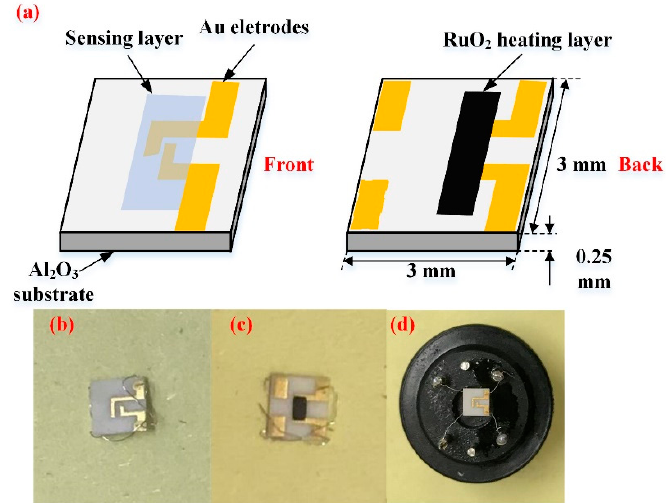
Figure 1. ( a ) Schematic diagram of the tungsten trioxide/reduced graphene oxide (WO 3 /rGO) nanocomposites ceramic planar gas sensor; ( b ) Photographs of the blank sensor (front); ( c ) Photographs of the blank sensor (back); and, ( d ) Photographs of the well-fabricated